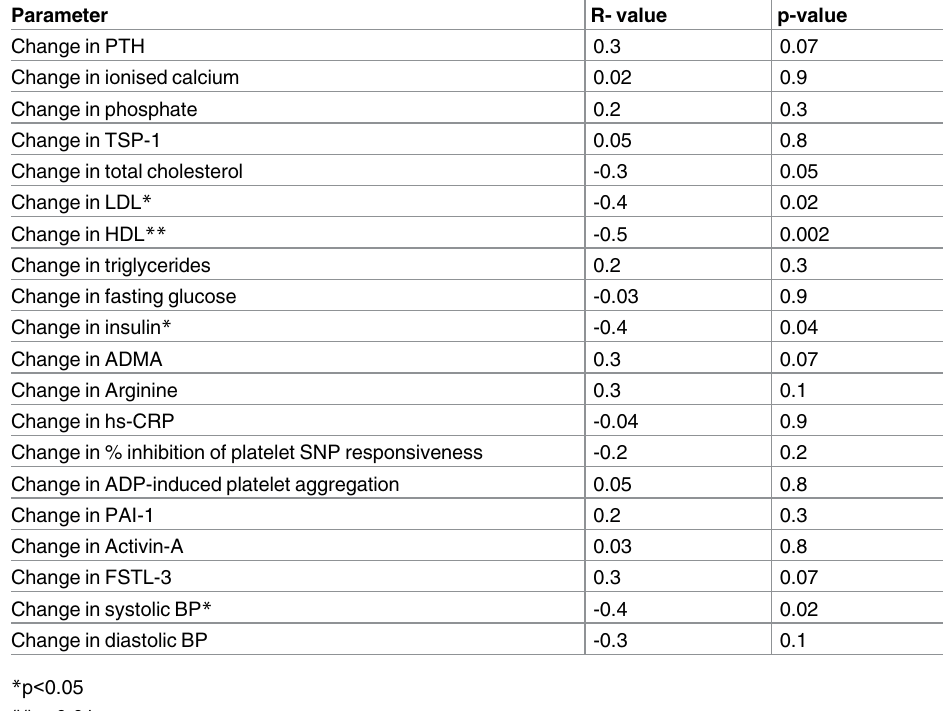
Table 3. Linear regression analyseswith change in 25-hydroxyvitamin D